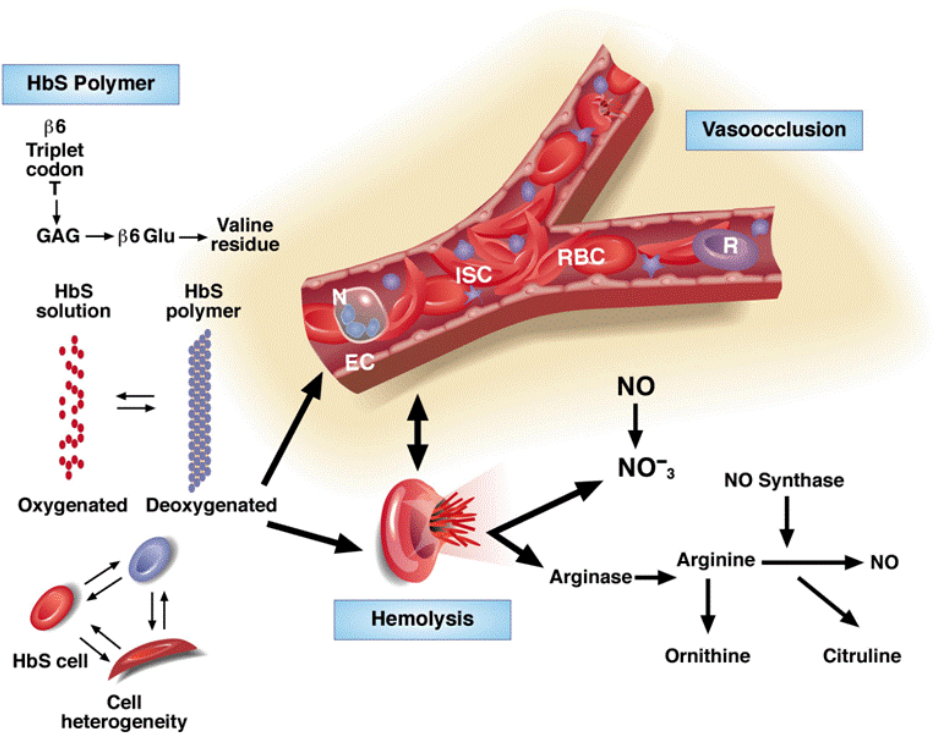
FIGURE 1. The pathophysiology of sickle cell disease. The HbS mutation, HBB glu6val, leads to β -globin chains that, when incorporated into hemoglobin tetramers with normal α -globin chains, produce a hemoglobin, HbS, which can undergo reversible polymerization when deoxygenated. The sickle polymer injures the erythrocyte and eventually produces irreversible membrane damage. These cells have a shortened life span (hemolysis), some of which occurs intravascularly consuming nitric oxide (NO). Sickle erythrocytes also lead to vasoocclusion. (From